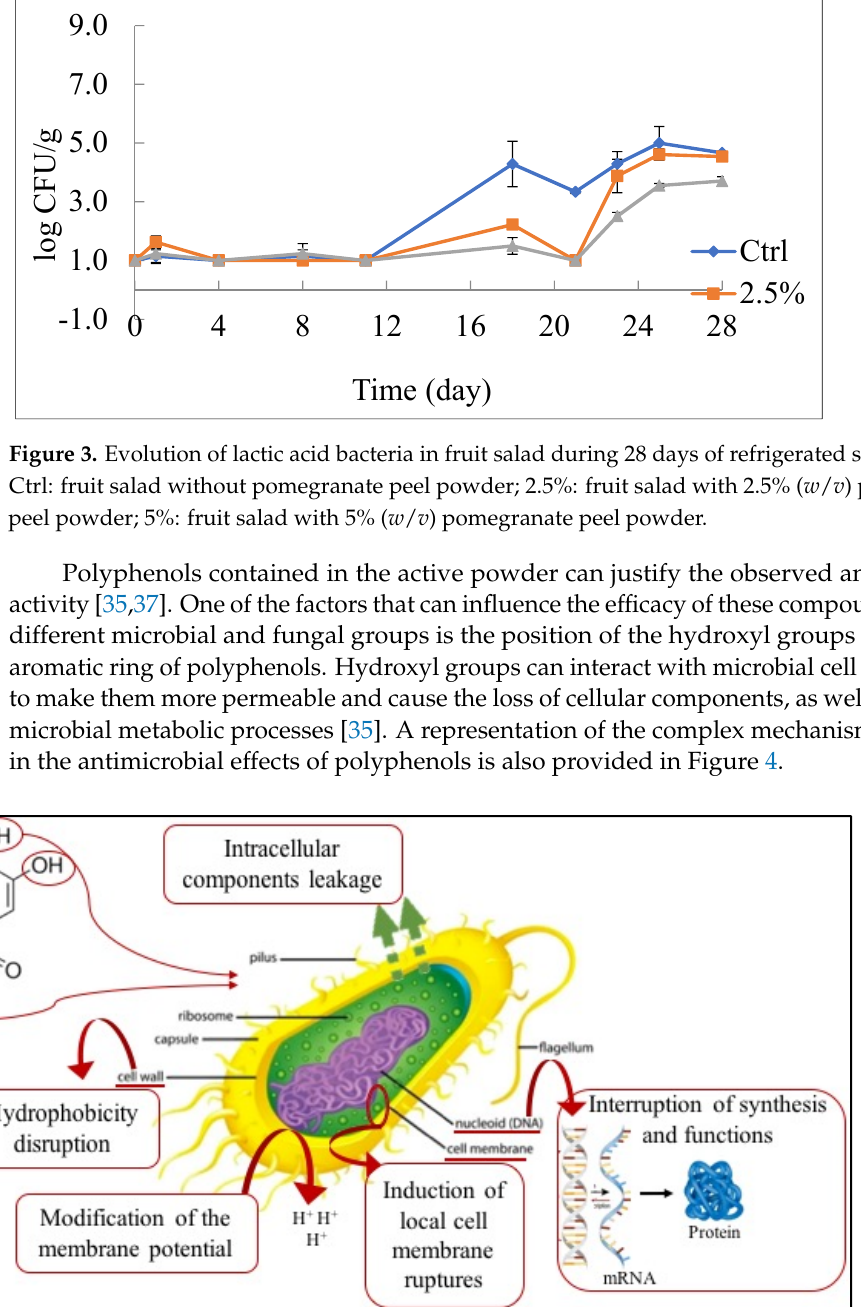
Figure 4. Mechanism of action of polyphenols on a microbial cell.